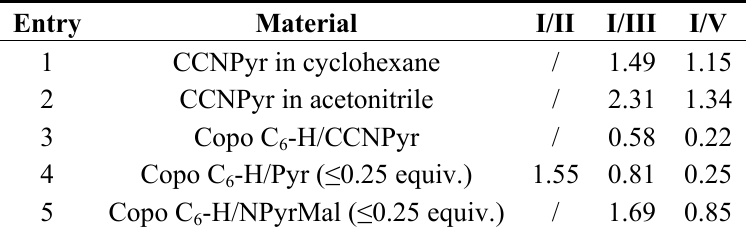
Table 1. Intensity ratios of pyrene bands in photoluminescence